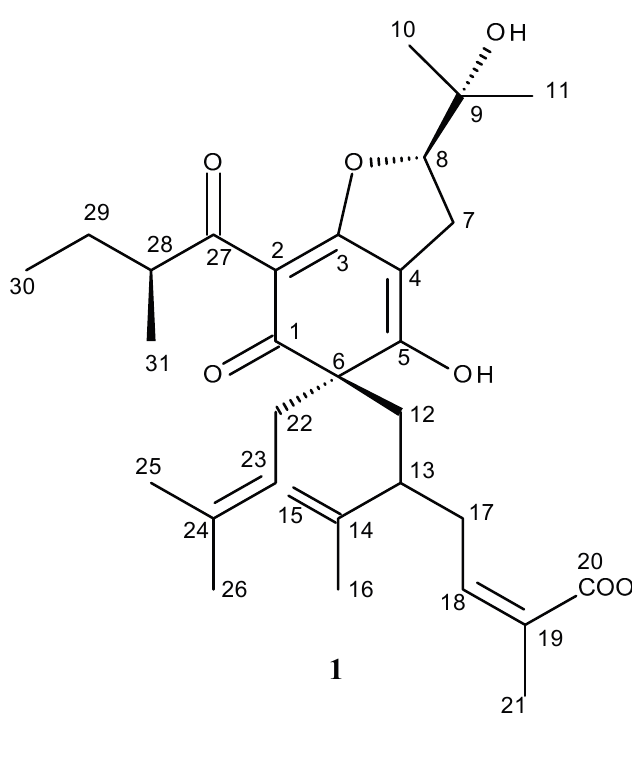
Figure 1. Structure of compound 1